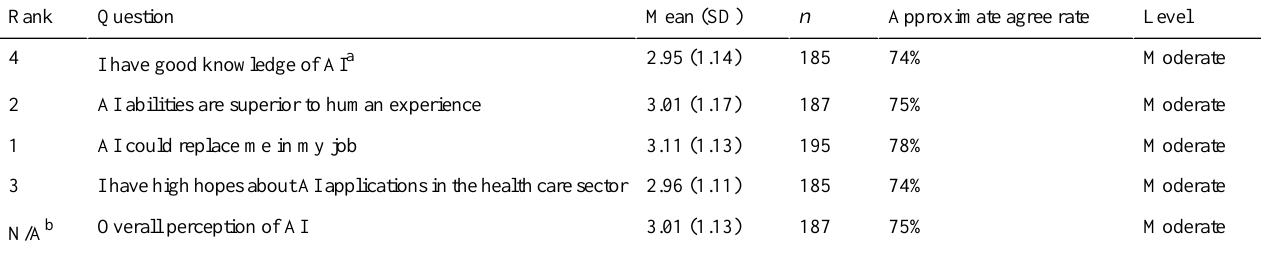
Table 3. Perceptions of AI (N=250).